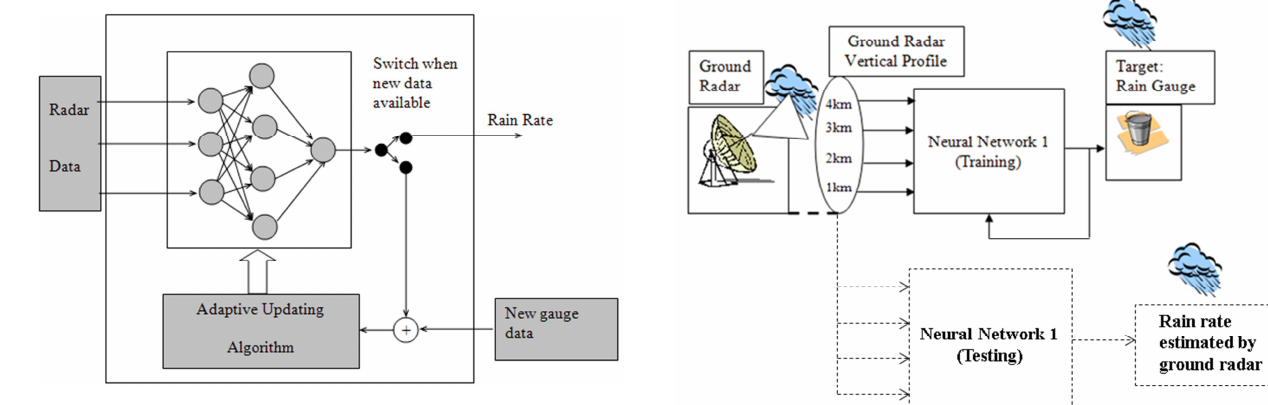
F IG . 4: Dynamic Neural network. Fig. 4. Dynamic Neural network.